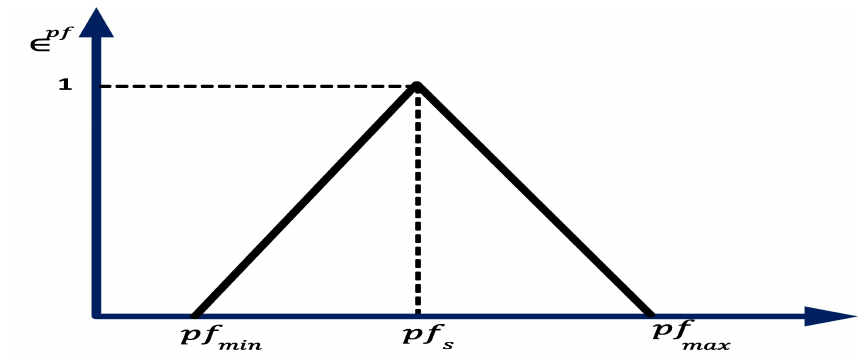
Figure 4. SS power